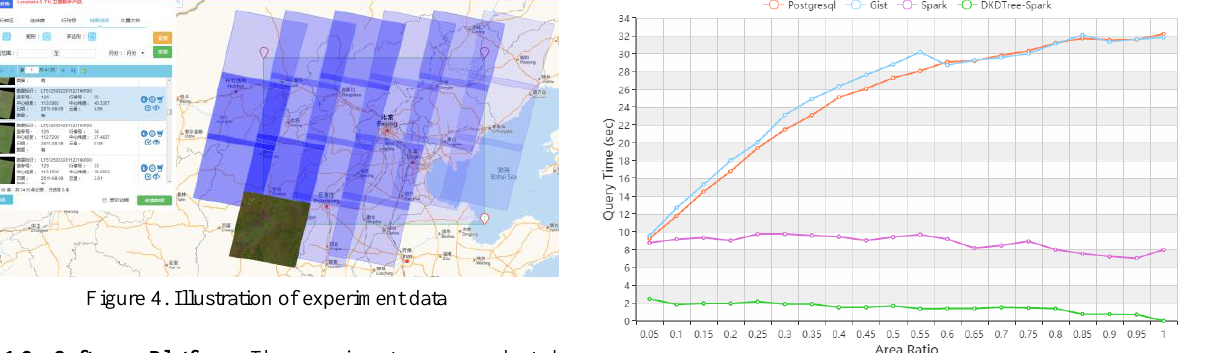
Figure 5. Counting Query in Different Sizes of the Query